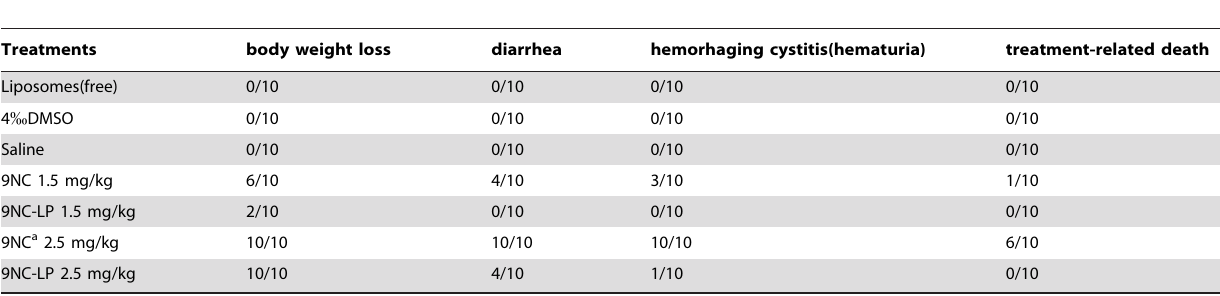
Table 3. Toxicity of 9NC and 9NC-LP in human hepatocellular carcinoma xenograft tumor model.